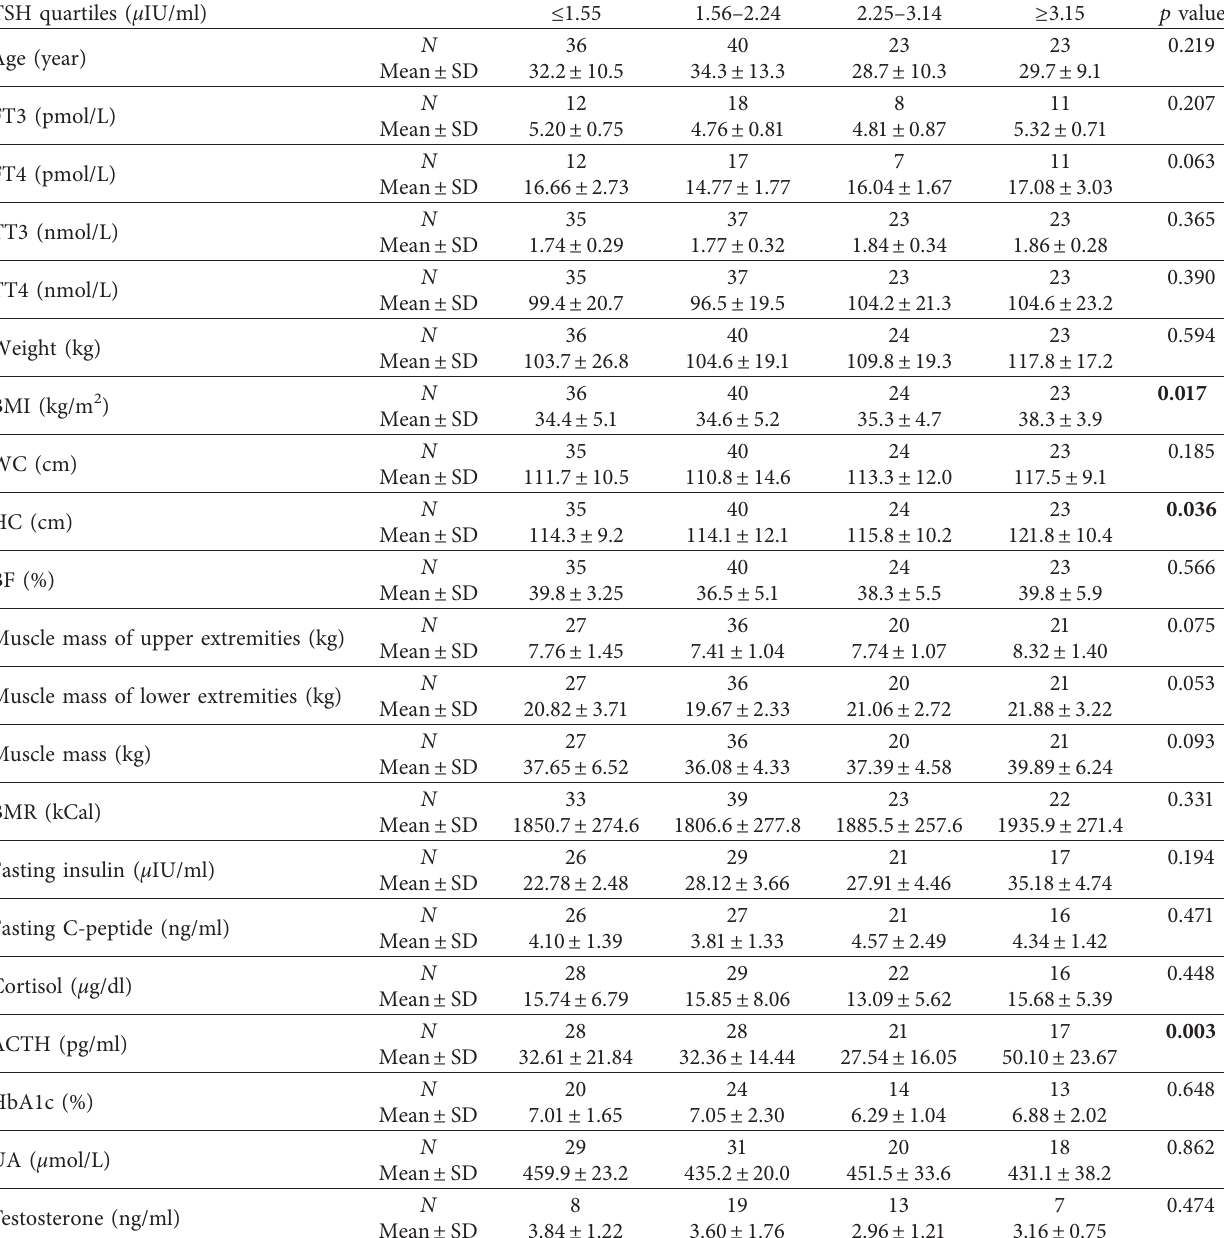
Table 3: The distribution of demographic data and metabolic indicators across the TSH quartiles in the male subgroup. TSH quartiles ( μ